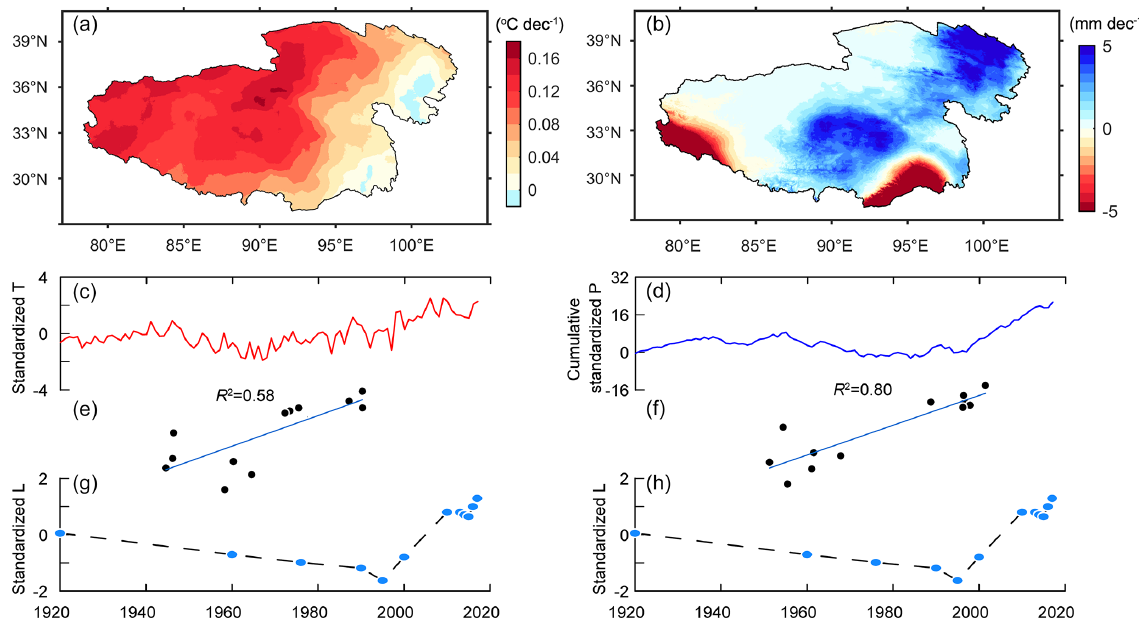
Figure 11. Spatial–temporal variations of temperature and precipitation from 1920 to 2017 and their correlations with lake area changes. (a) Spatial pattern of temperature change. (b) Spatial pattern of precipitation change. (c) Time series of standardized temperature ( T ). (d) Time series of cumulative standardized precipitation ( P ). (e) Correlation between standardized temperature and standardized lake area. (f) Correlation between cumulative standardized precipitation and standardized lake area. (g,h) Standardized lake